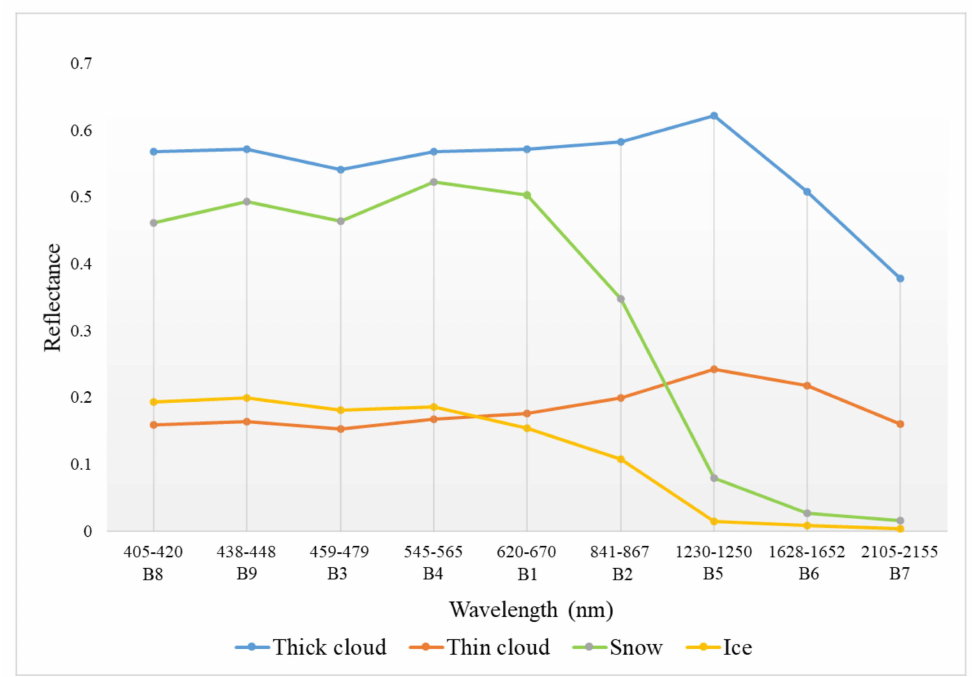
Figure 2. The variation of the reflectance of four types of pixels in different spectral ranges. See text for